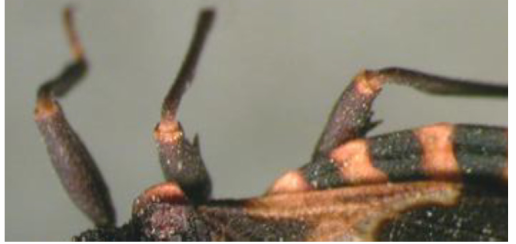
7. -Legs black with an orange-red color at the apex of each femur and bases of